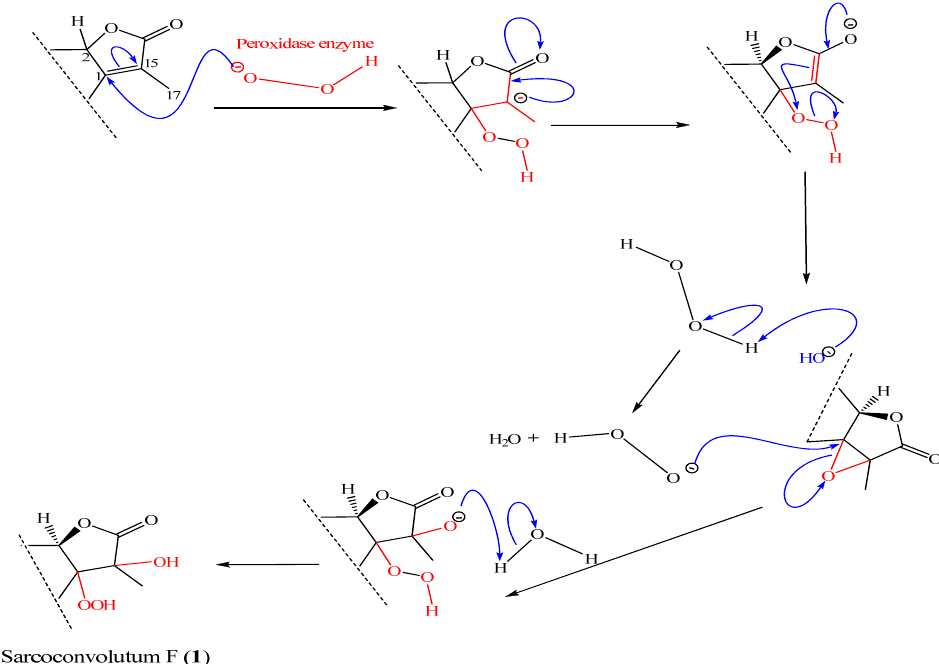
Figure 6. Biogenesis route of Sarcoconvolutum F ( 1 ).